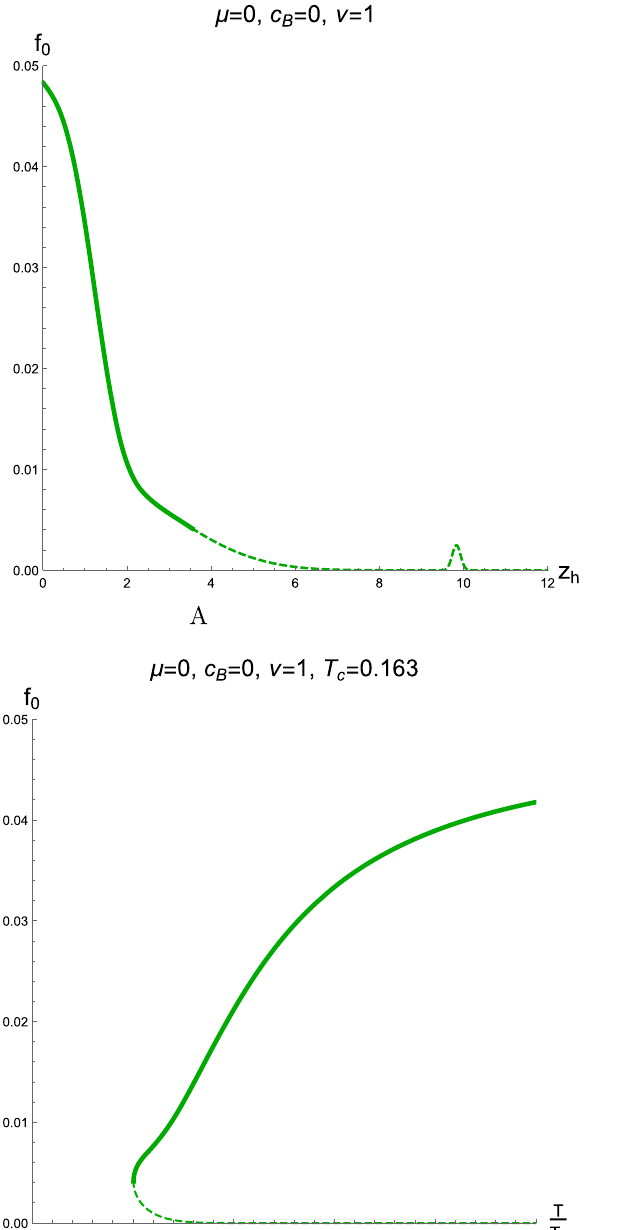
approaching some constant value between 0.3 and 0.31 that is the same for all parameters. This asymptotic value can be adjusted with an overall factor in f 0